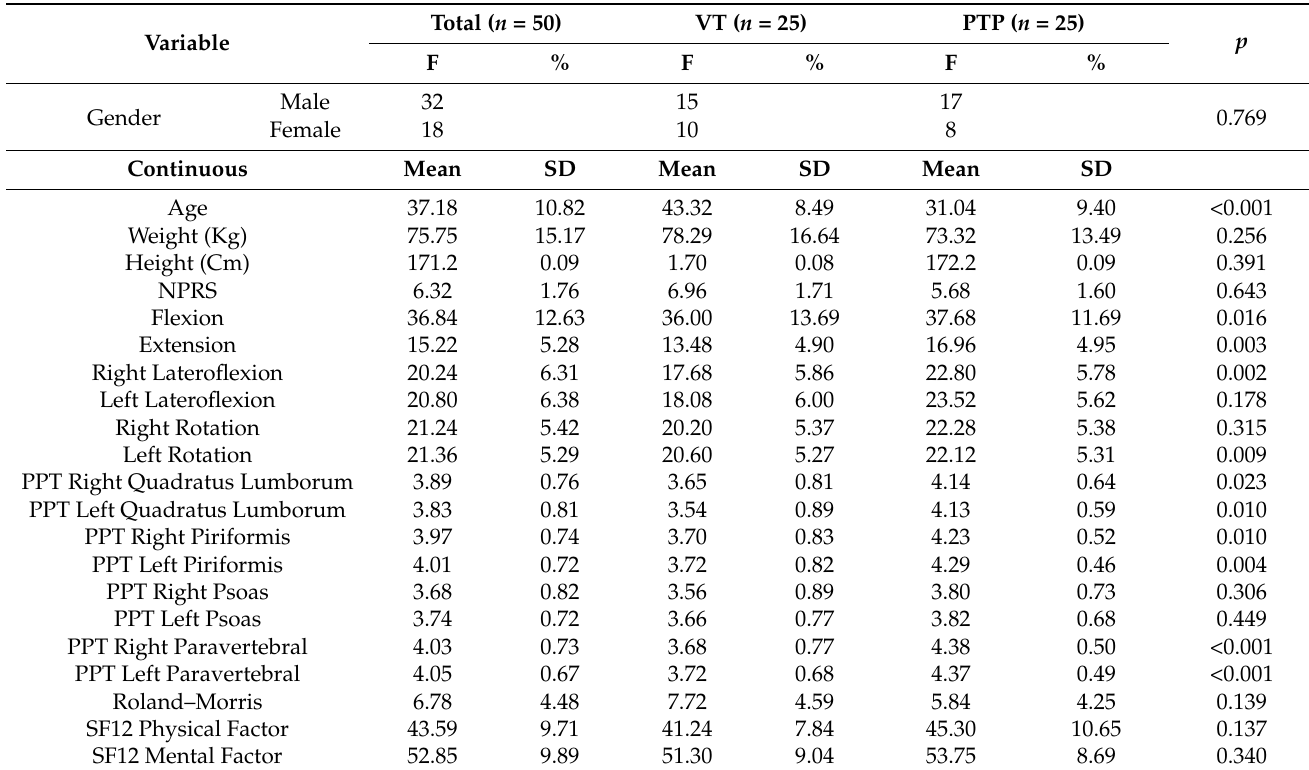
Table 1. Descriptive data and clinical characteristics of the sample at